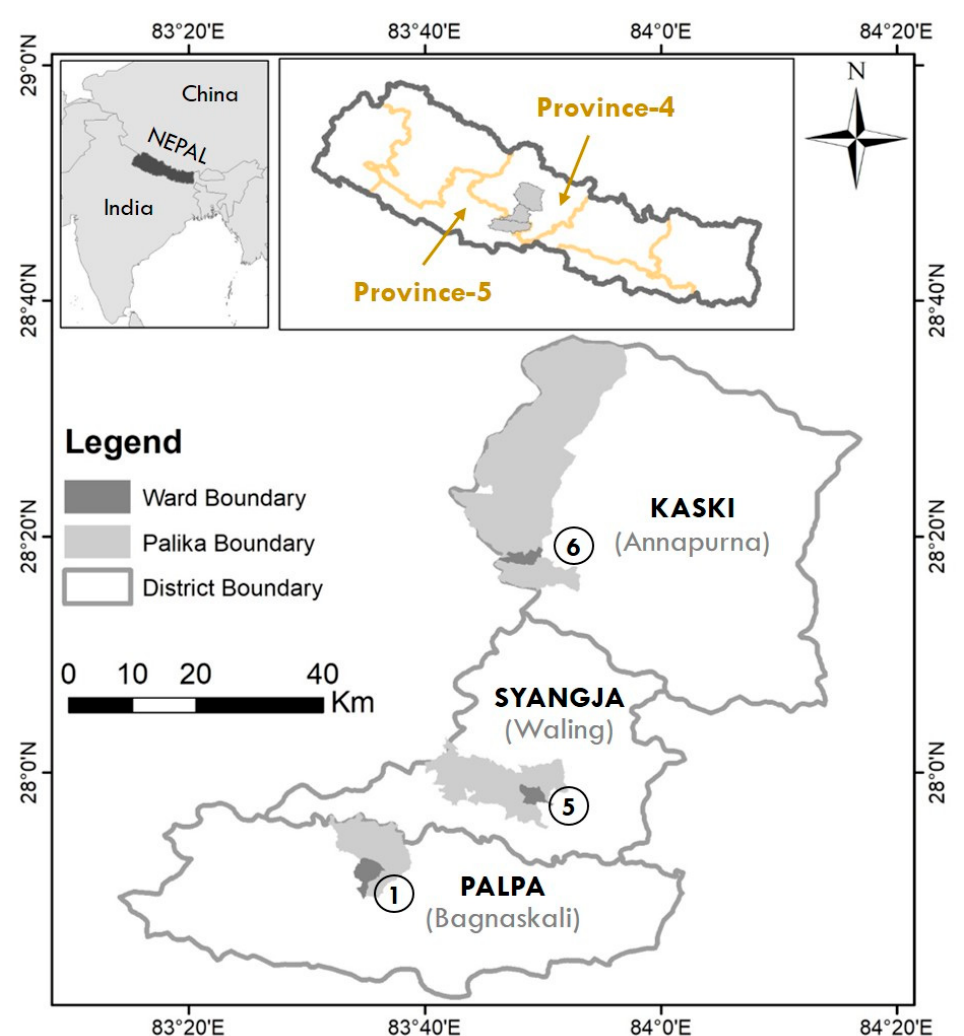
Figure 1. Map of the study area highlighting the three research sites in Annapurna-6, Waling-5, and Bagnaskali-1